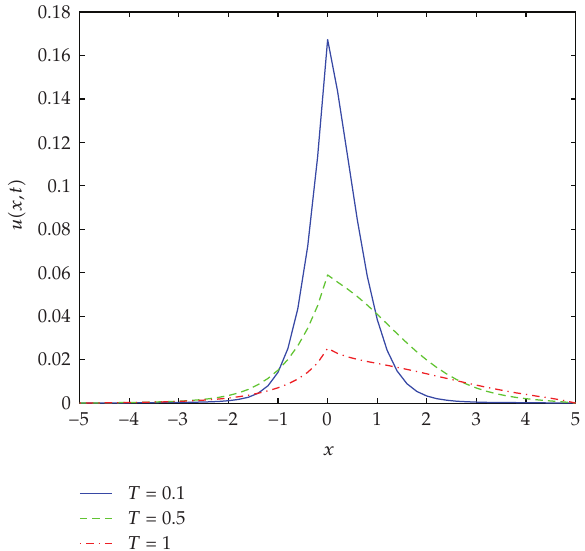
Figure 6: Numerical solutions for Example 5.3 with α (cid:7) 0 . 8 and μ (cid:7) 1 . 8 at di ff erent times T (cid:7) 0 . 1 , 0 . 5 , 1 . 0.